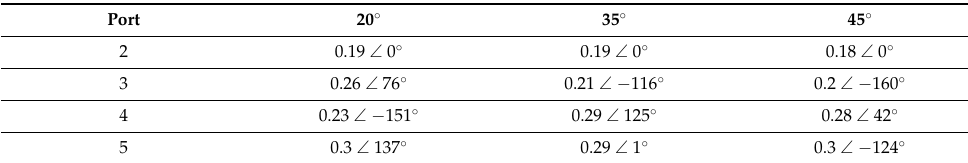
Table 1. 20 ◦ , 35 ◦ and 45 ◦ beam tilting